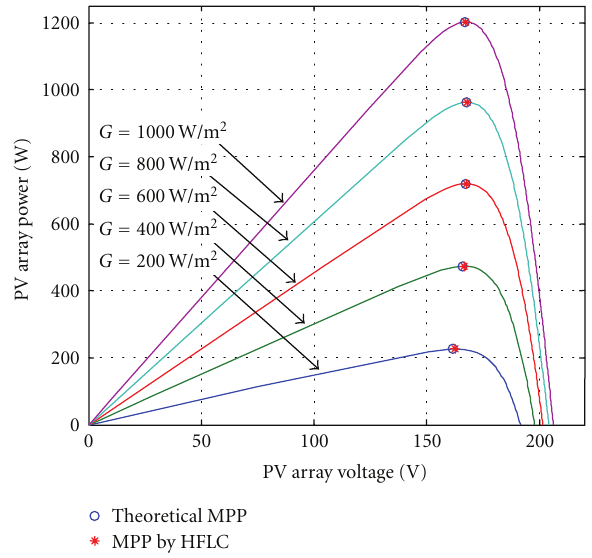
Figure 12: Performance of the HFLC-based MPPT under various irradiation at constant temperature T = 25 ◦ C.